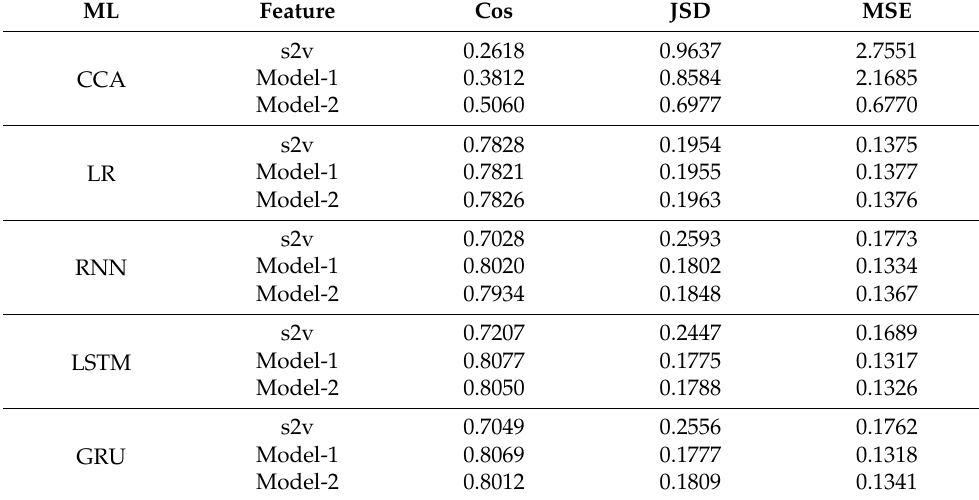
Table 19. Comparison of cosine, JSD, and MSE